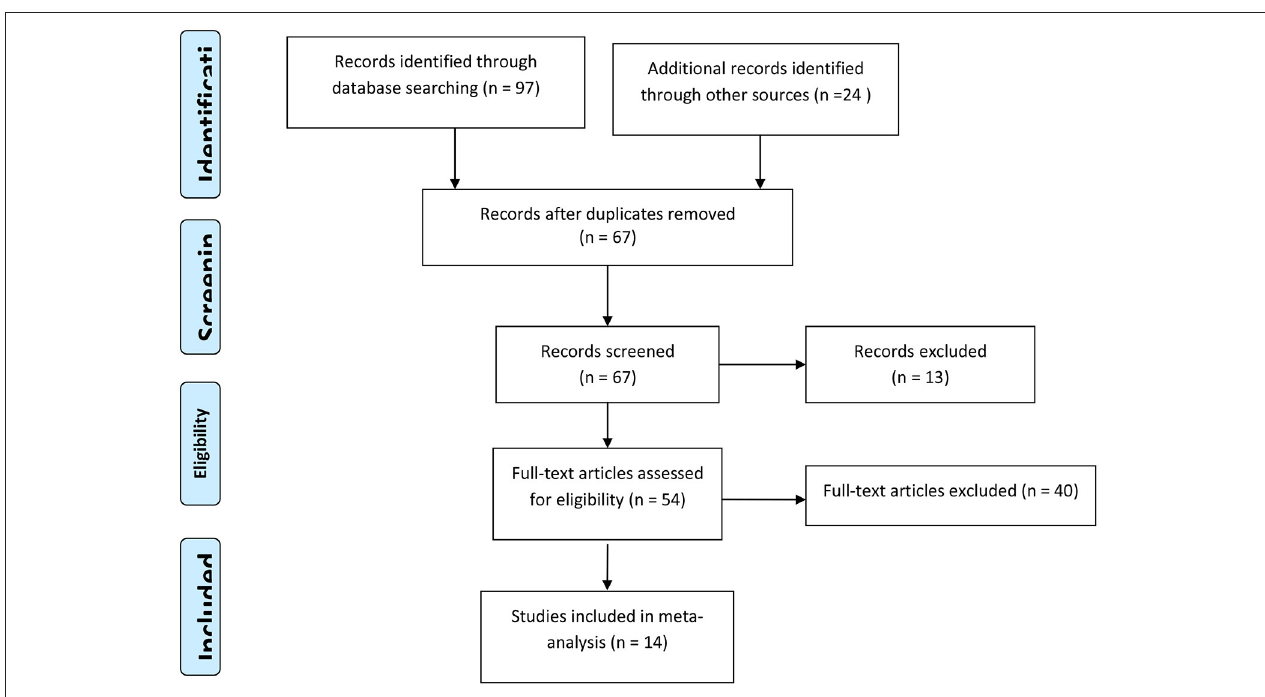
FIGURE 1 | PRISMA flow diagram for included